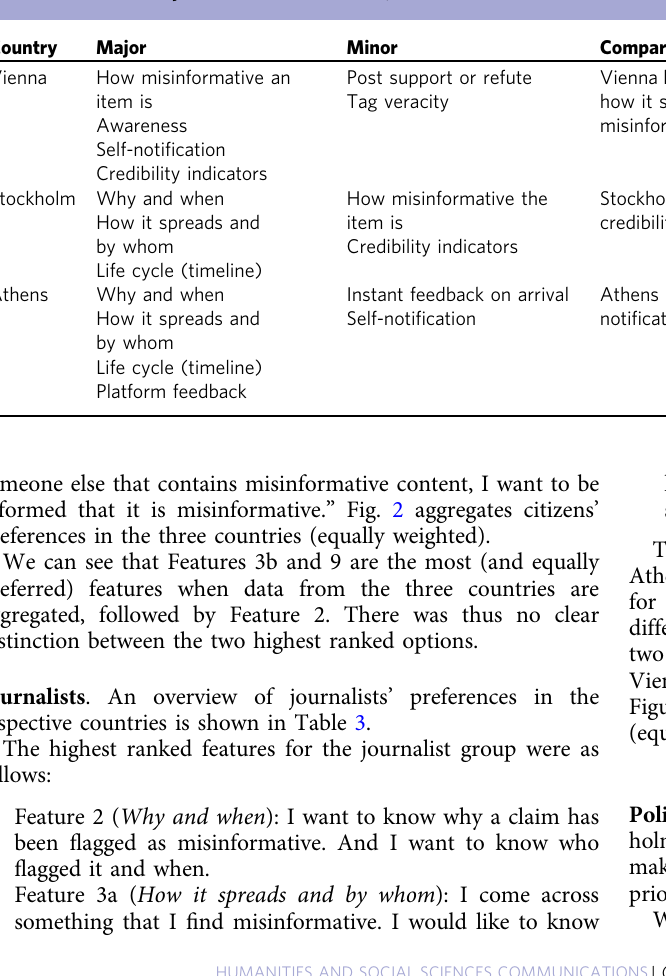
Table 3 Journalist preferences in Vienna, Stockholm and